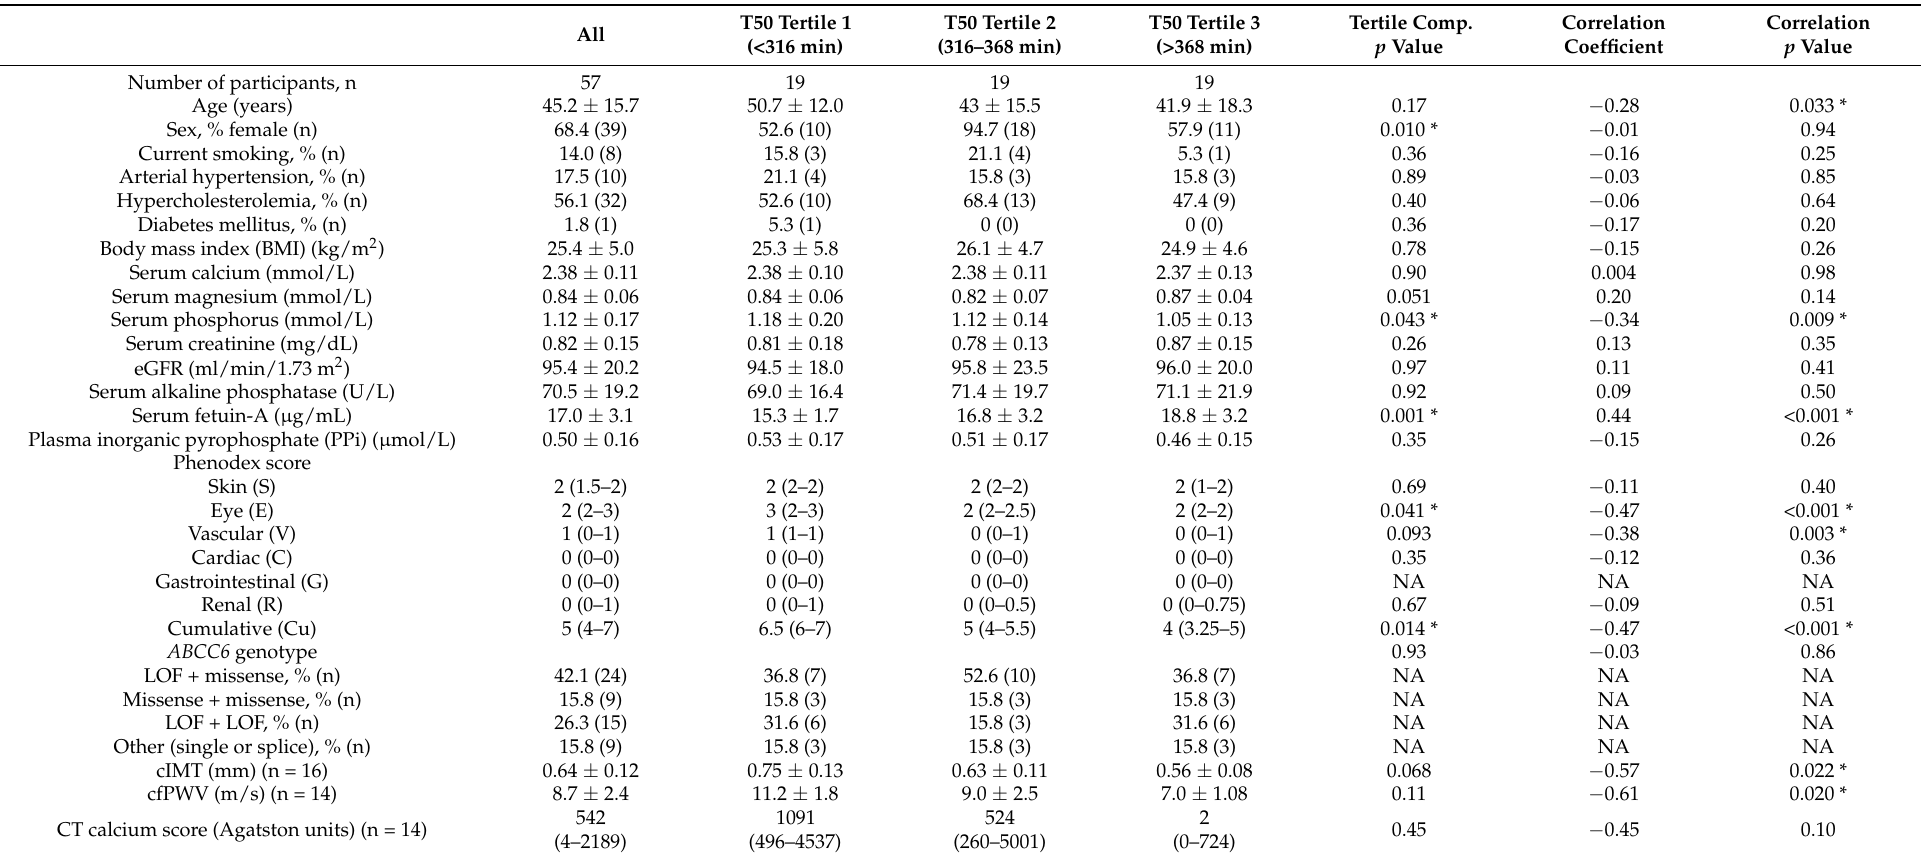
Table 1. Baseline characteristics of the study